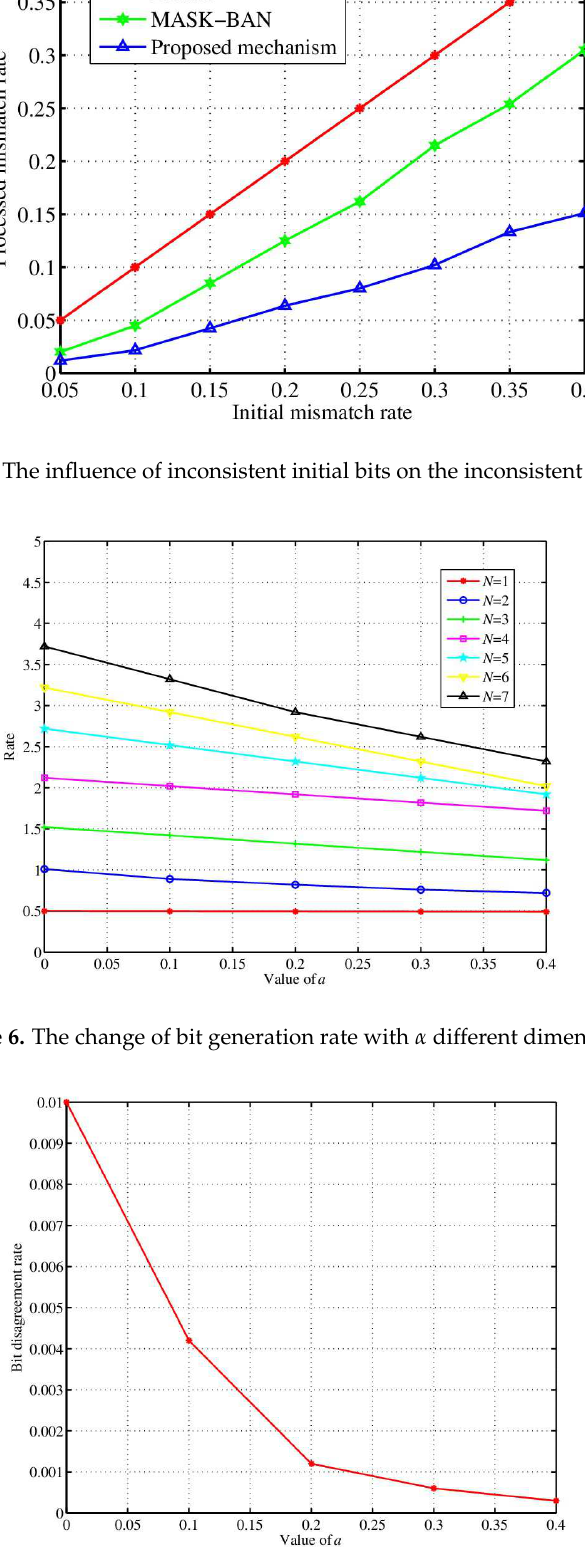
Figure 7. The variation of bit inconsistency with α